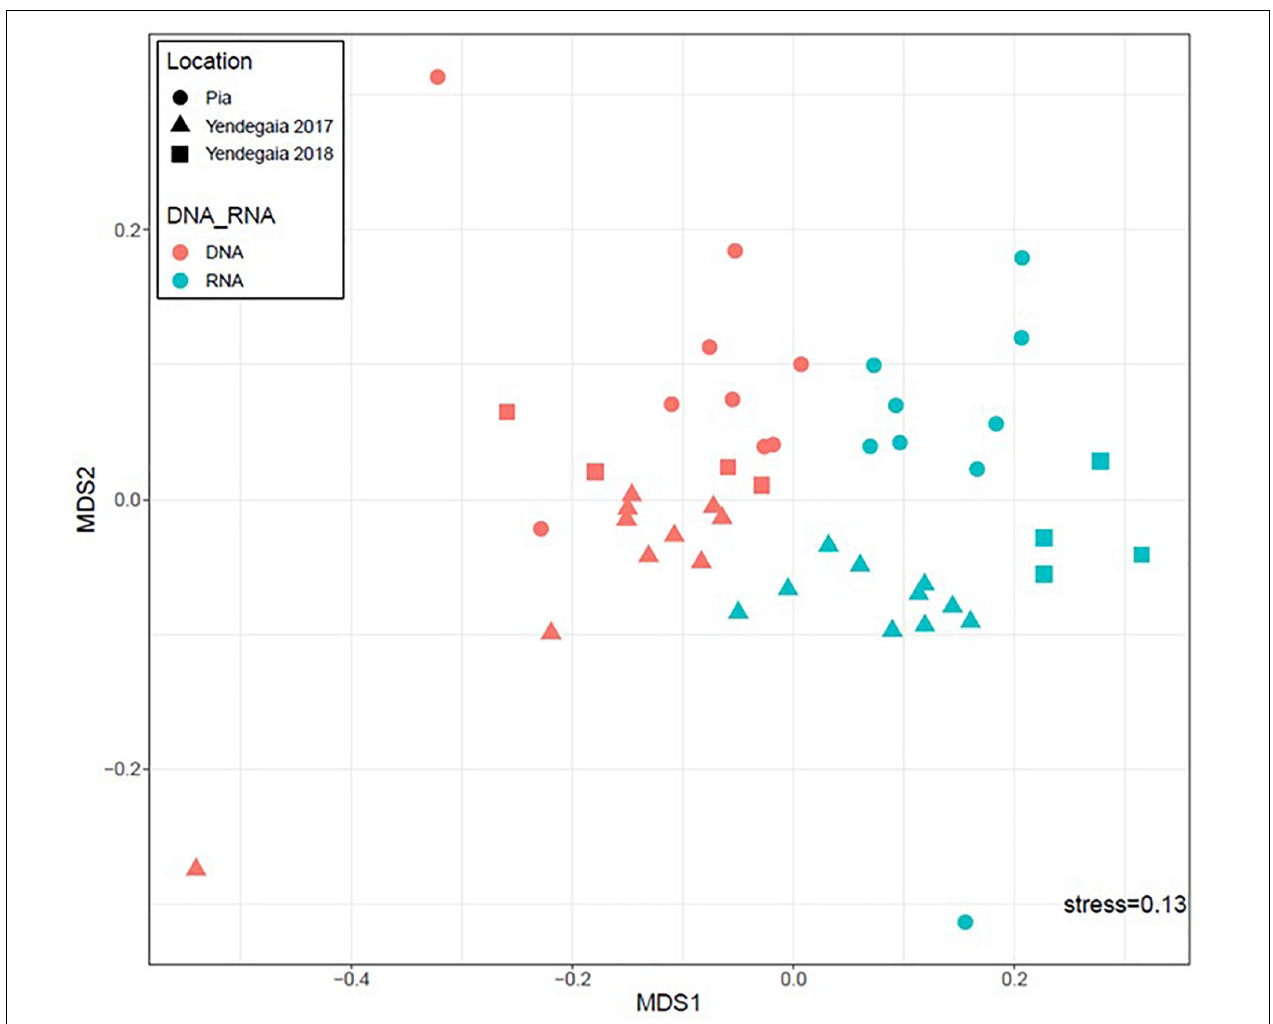
FIGURE 3 | Non-metric multidimensional scaling ordination (NMDS) based on Bray–Curtis similarity analysis of microbial community composition. Colors represent DNA communities (red) and RNA communities (blue). Shapes represent the sampling sites: Pia fjord (circle), Yendegaia fjord year 2017 (triangle), and Yendegaia fjord year 2018